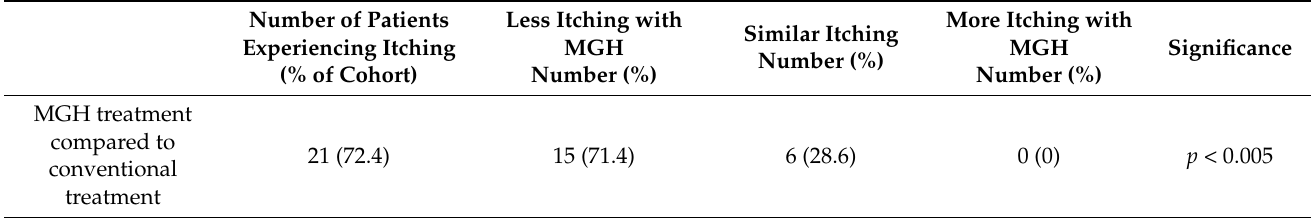
Table 3. Relative itching when comparing MGH treatment with conventional